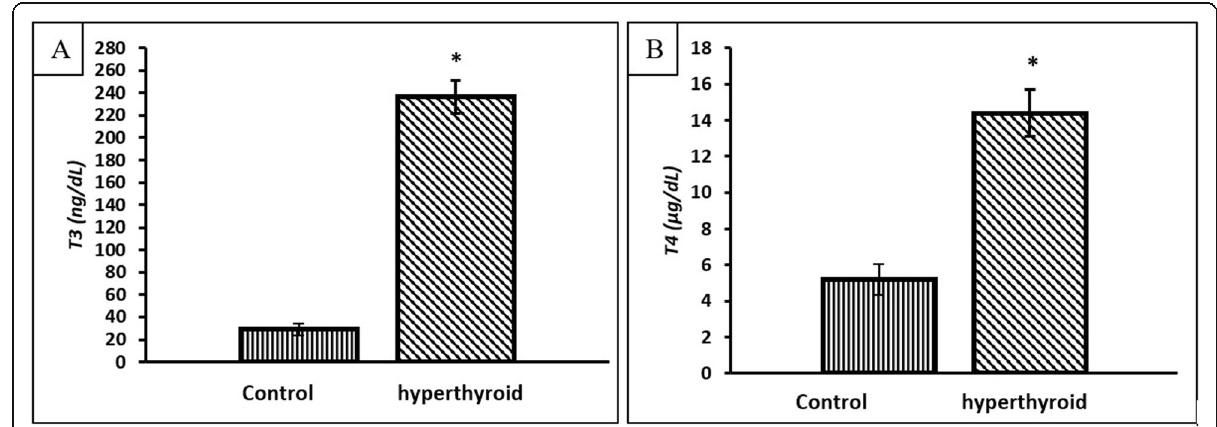
Fig. 1 Evaluation of serum levels of thyroid hormones. a T3. b T4. n = 10 rats in the control group and 30 rats in hyperthyroid. Data are represented as mean ± standard deviation. *Differs significantly from the control group with p < 0.